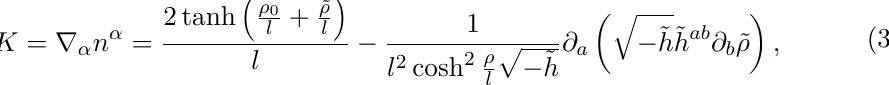
JHEP02(2023)219